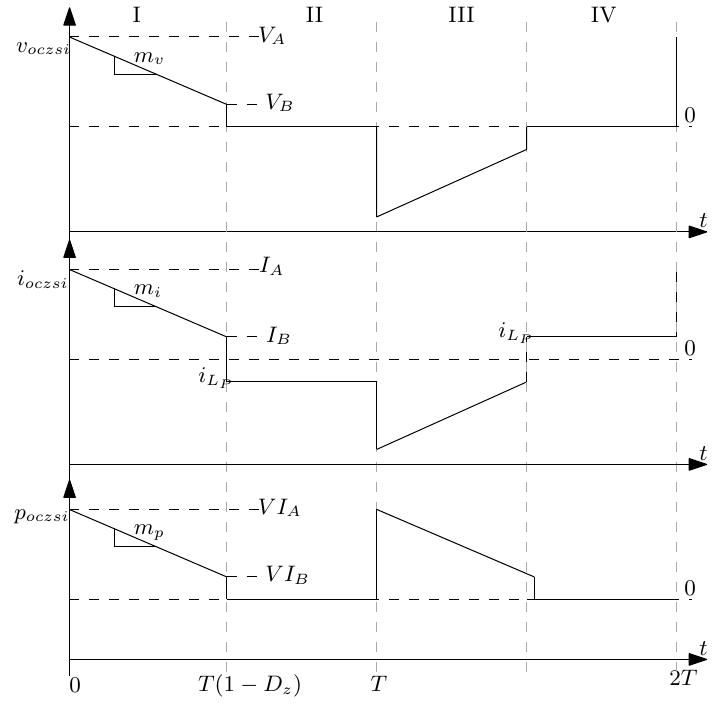
Figure 4. CZSI Output: V oczsi , i oczsi , and power p oczsi